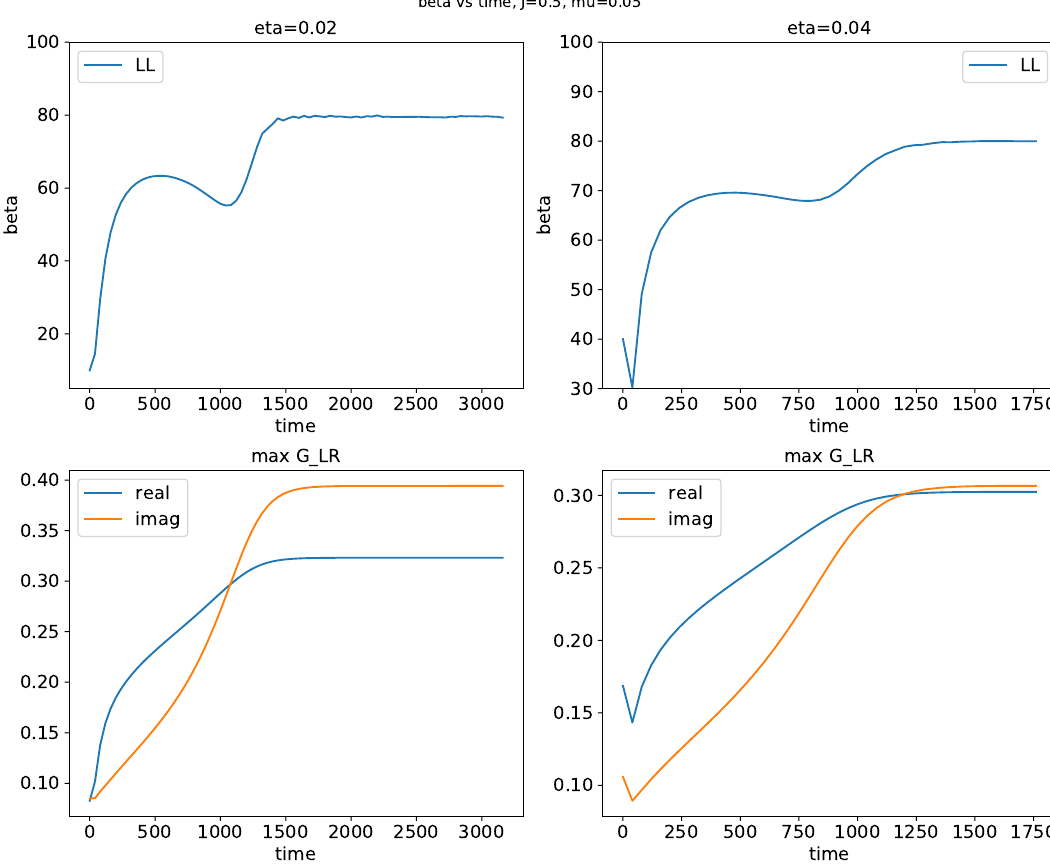
Figure 9 . (Upper part) β as a function of time for η = 0 . 02 and 0 . 04 . (Lower part) the maximum of value of G for the same values of η LR